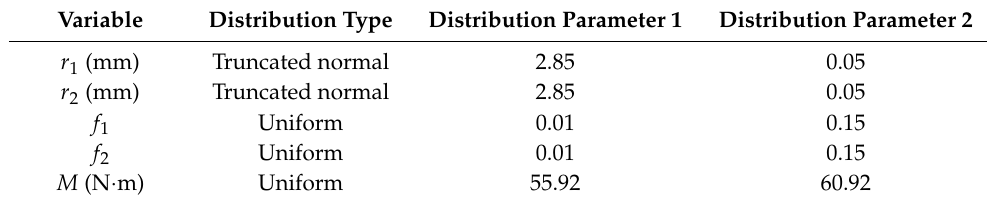
Table 6. Distributions of random